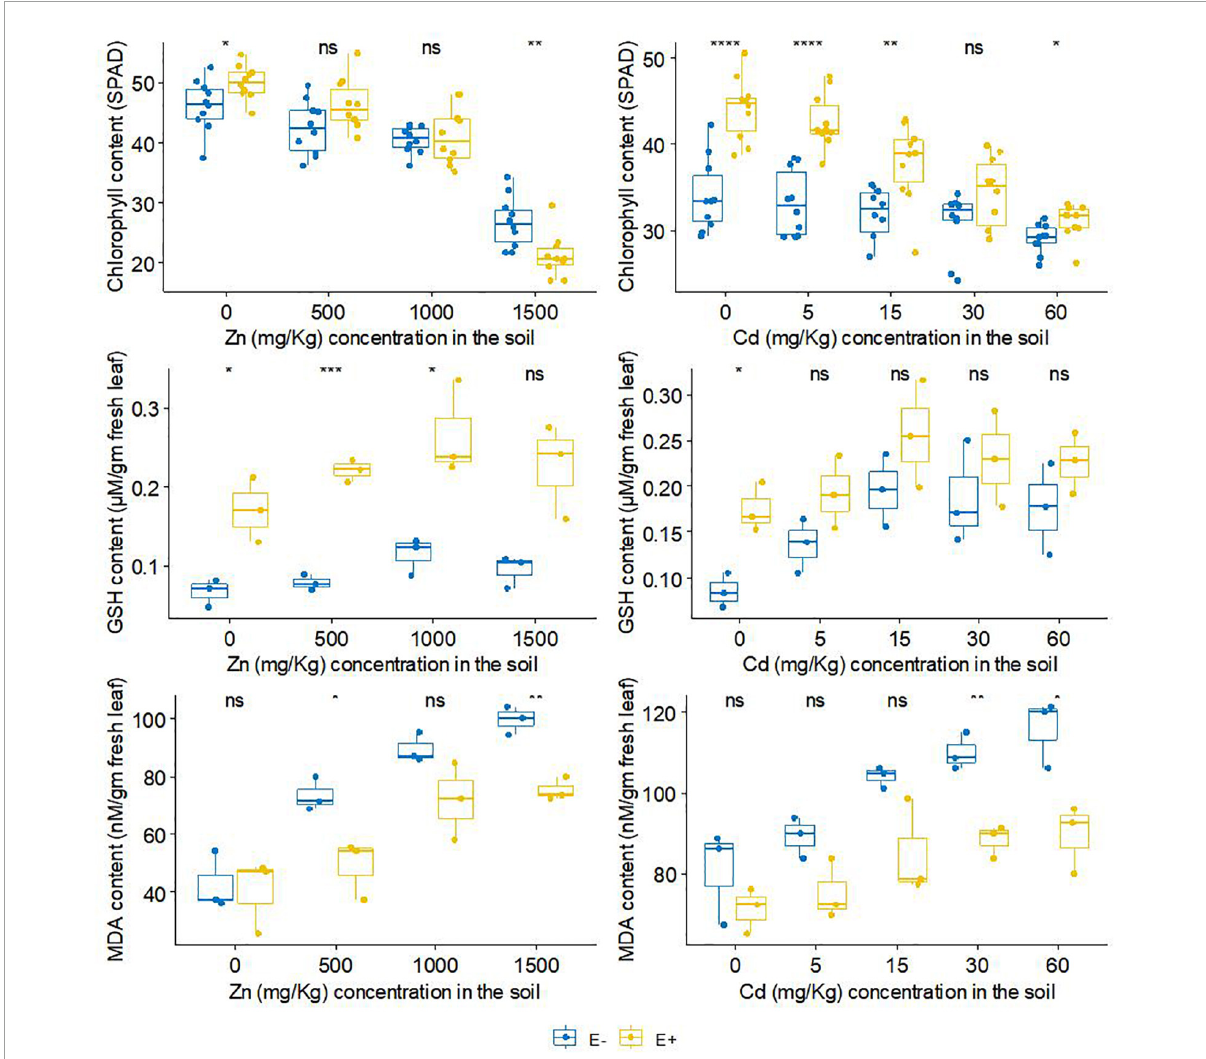
FIGURE4 The effect of FXZ2 on the Chlorophyll, GSH and MDA content of Dysphania ambrosioides under Zn/Cd stress (* p < 0.05, ** p < 0.005, *** p < 0.0005, **** p < 0.00005, ns p > 0.05 t -test).